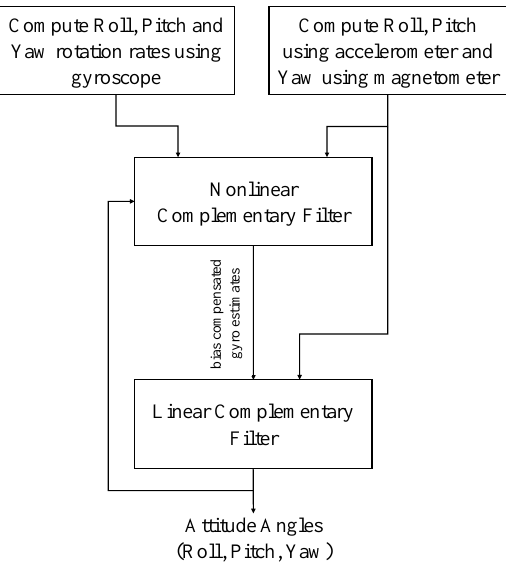
Figure 7. Flowchart of the proposed CCF